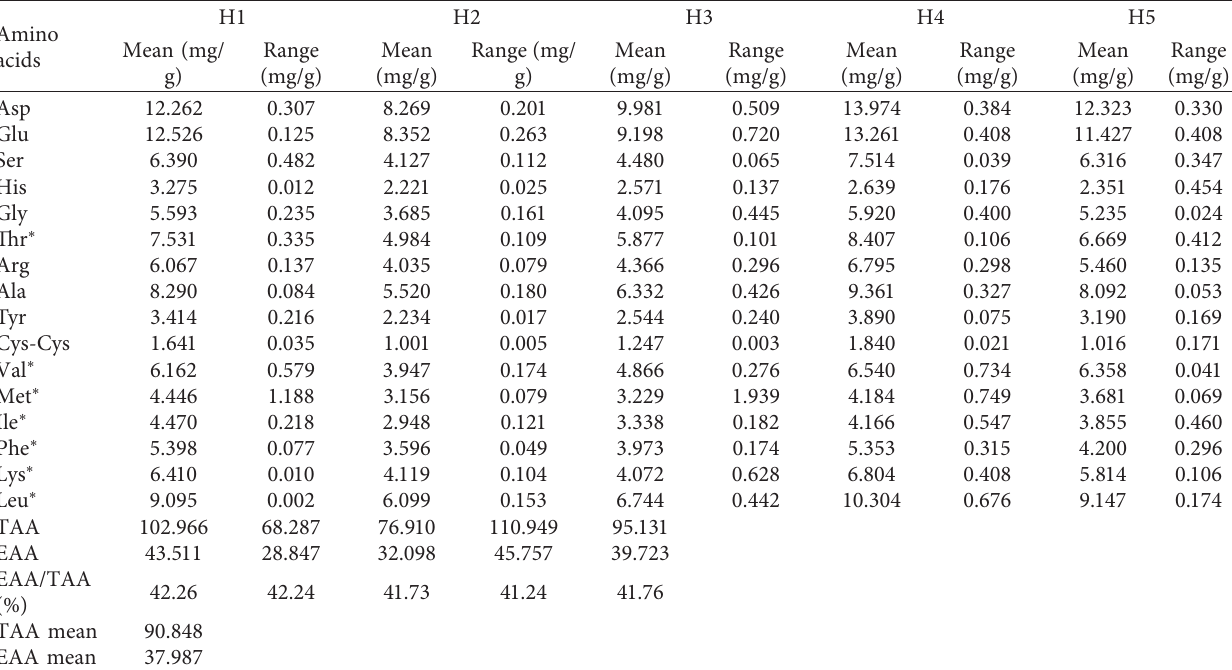
Table 2: Determination of amino acids in A. auricula from Heilongjiang.